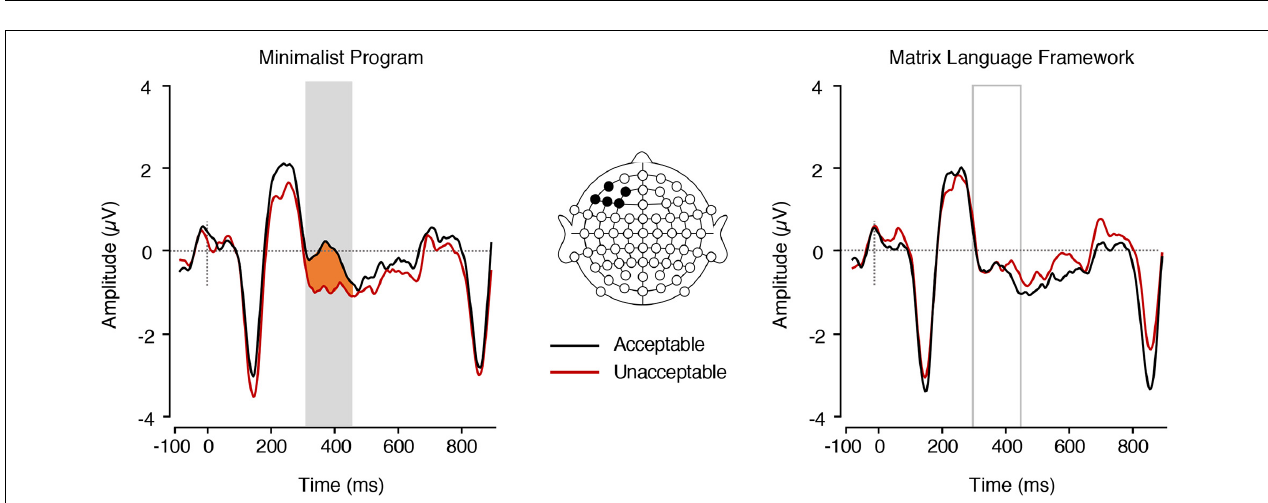
FIGURE 2 | Topographic maps of ERP difference waves elicited by the adjective and the noun in the LAN and P600 analysis windows. Main effect of MLF depicts differences between sentences that violated MLF and sentences that adhered to MLF. Main effect of MP depicts differences between sentences that violated MP and sentences that adhered to MP.